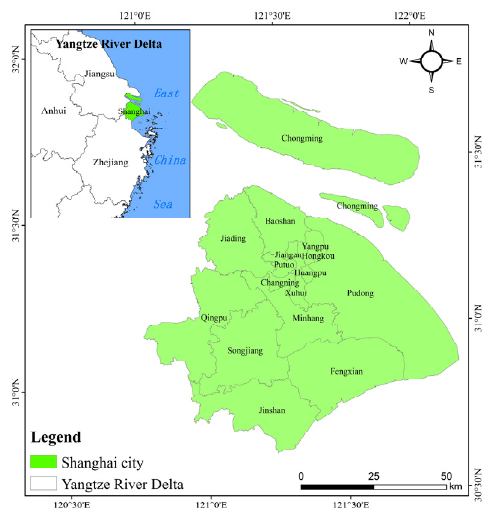
Figure 1. Research area.